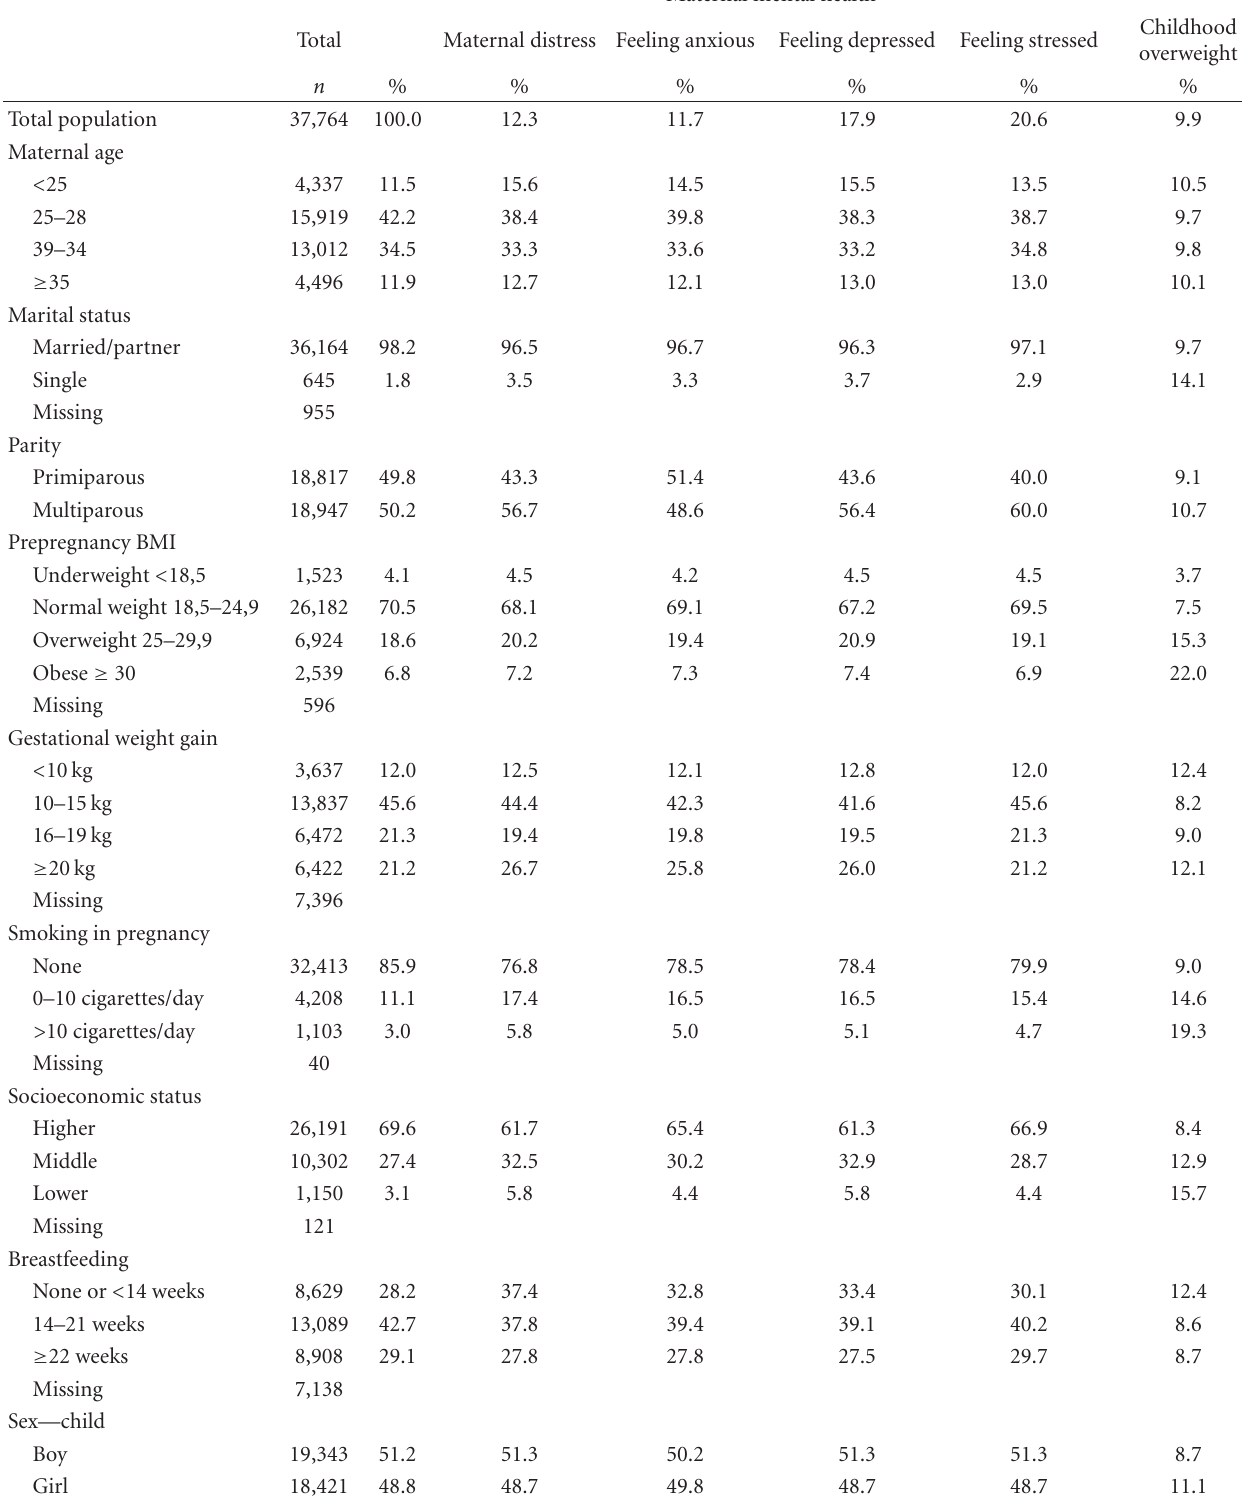
Table 2: Maternal distress during pregnancy covering anxiety, depression, and stress, and childhood overweight according to maternal